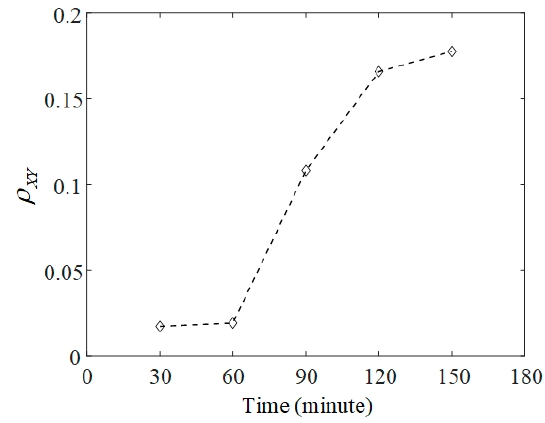
Figure 7. Phase synchronization indicator for accelerated failure.